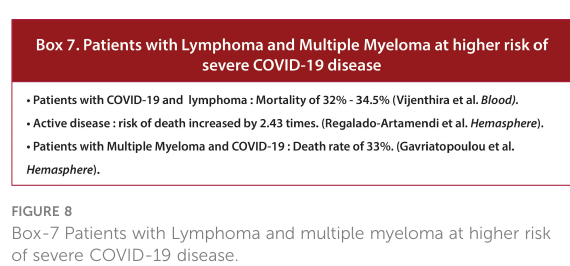
FIGURE 7 Box-6: Hematological malignancy.